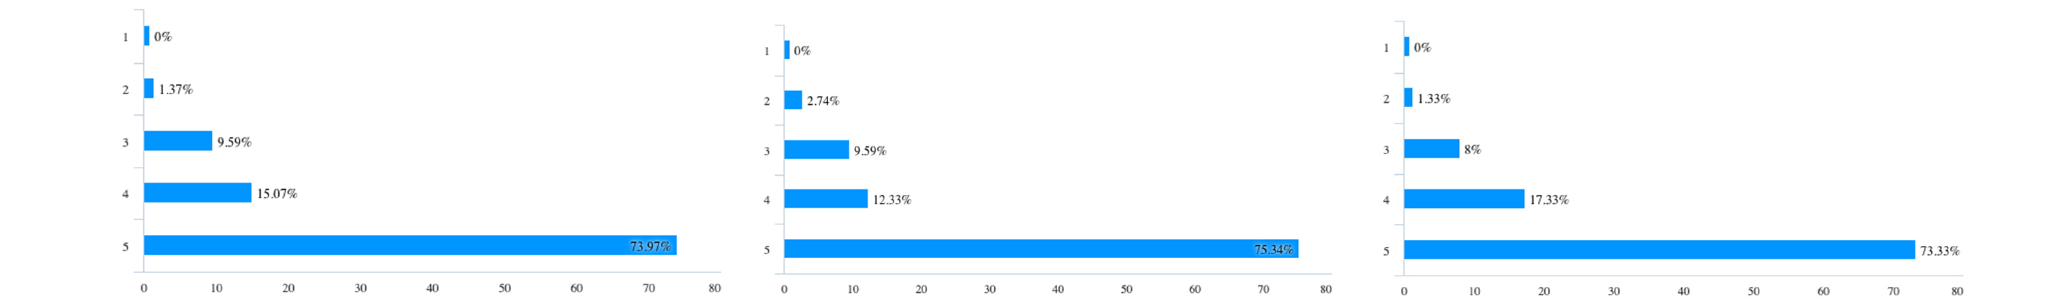
Figure A1. People’s perception of the similarity of hue, brightness and saturation between the reality and virtual reality (1 = Dissimilar, 2 = Slightly dissimilar, 3 = Slightly similar, 4 = Similar, 5 = Same).